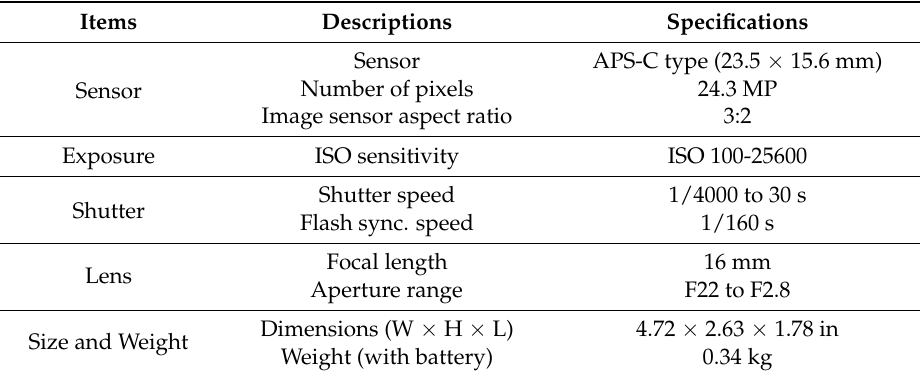
Table 3. Specifications of the visible-light camera.